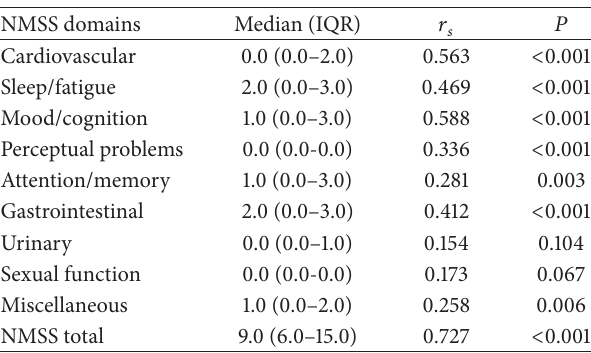
Table 4: Correlation between NMSS domains and PDQ-39